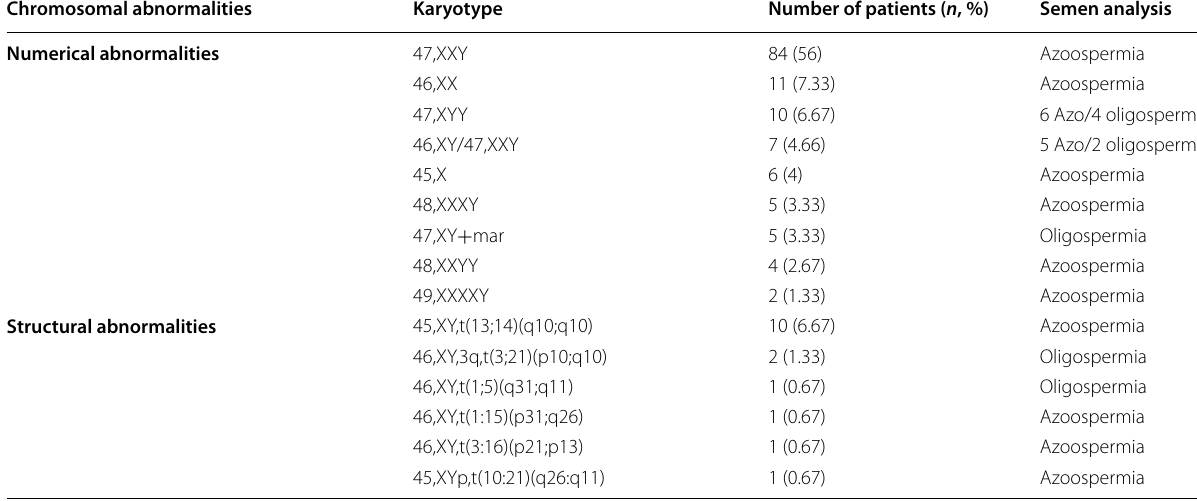
Data are expressed as numbers and percentages